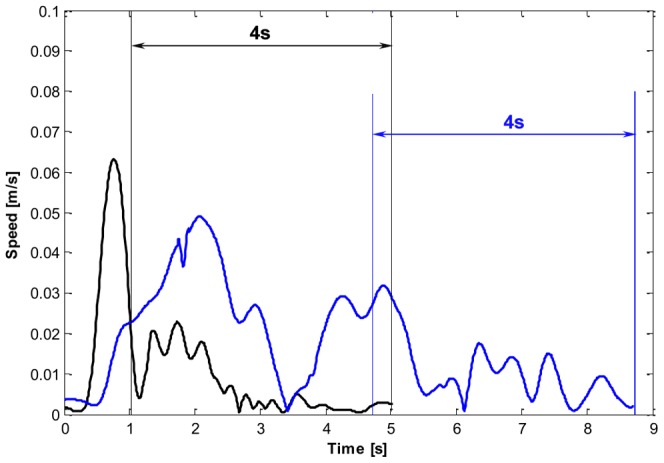
Task A: typical speed profiles of the tool-tip.The figure shows typical speed profiles of a well-trained subject when using the two strategies (SSS: black curve; PSS: blue curve). The initial time corresponds to the presentation of a new target for both strategies. Both profiles include the time-to-target (about 1 s for SSS and 4.8 s for PSS) and the 4 s dwell time, during which residual oscillations of the tool tip remain inside the target area.